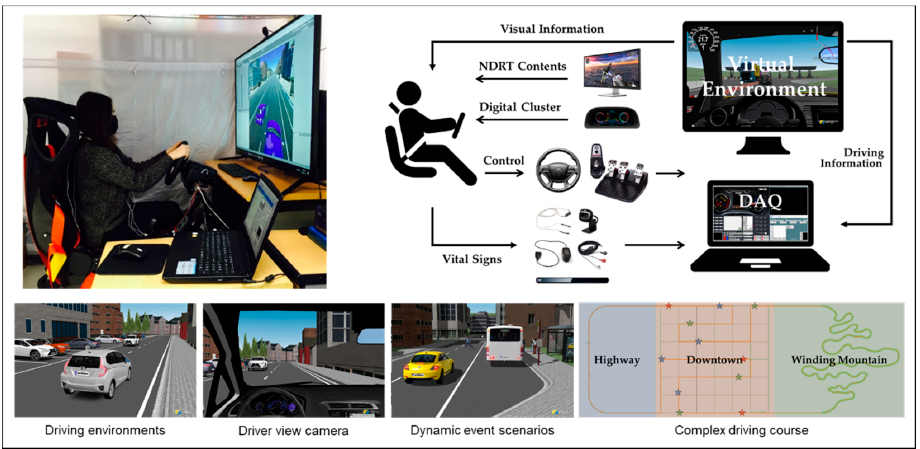
Figure 3. HITL simulator